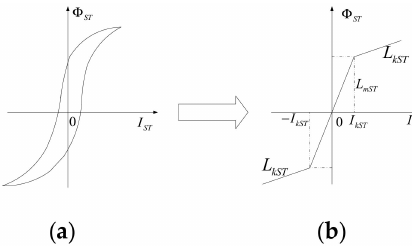
Figure 3. Relationship of the transformer flux-exciting current. ( a ) Transformer flux-exciting current curve; ( b ) Transformer flux-exciting current curve after piece-wise